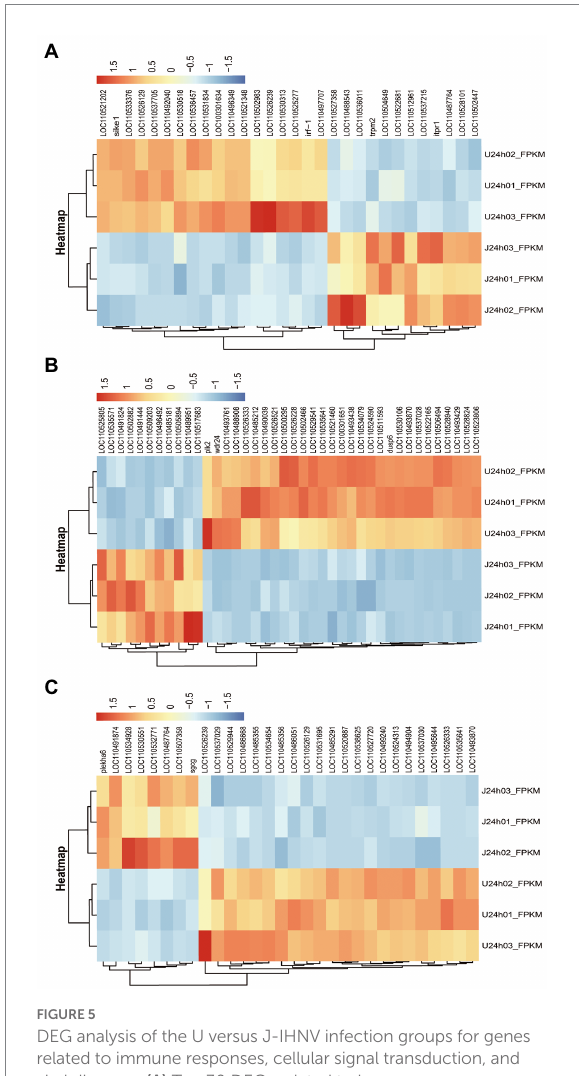
FIGURE 5 DEG analysis of the U versus J-IHNV infection groups for genes related to immune responses, cellular signal transduction, and viral diseases. (A) Top 30 DEGs related to immune responses. (B) Top 40 DEGs related to cellular signal transduction. (C) Top 30 DEGs related to viral diseases.